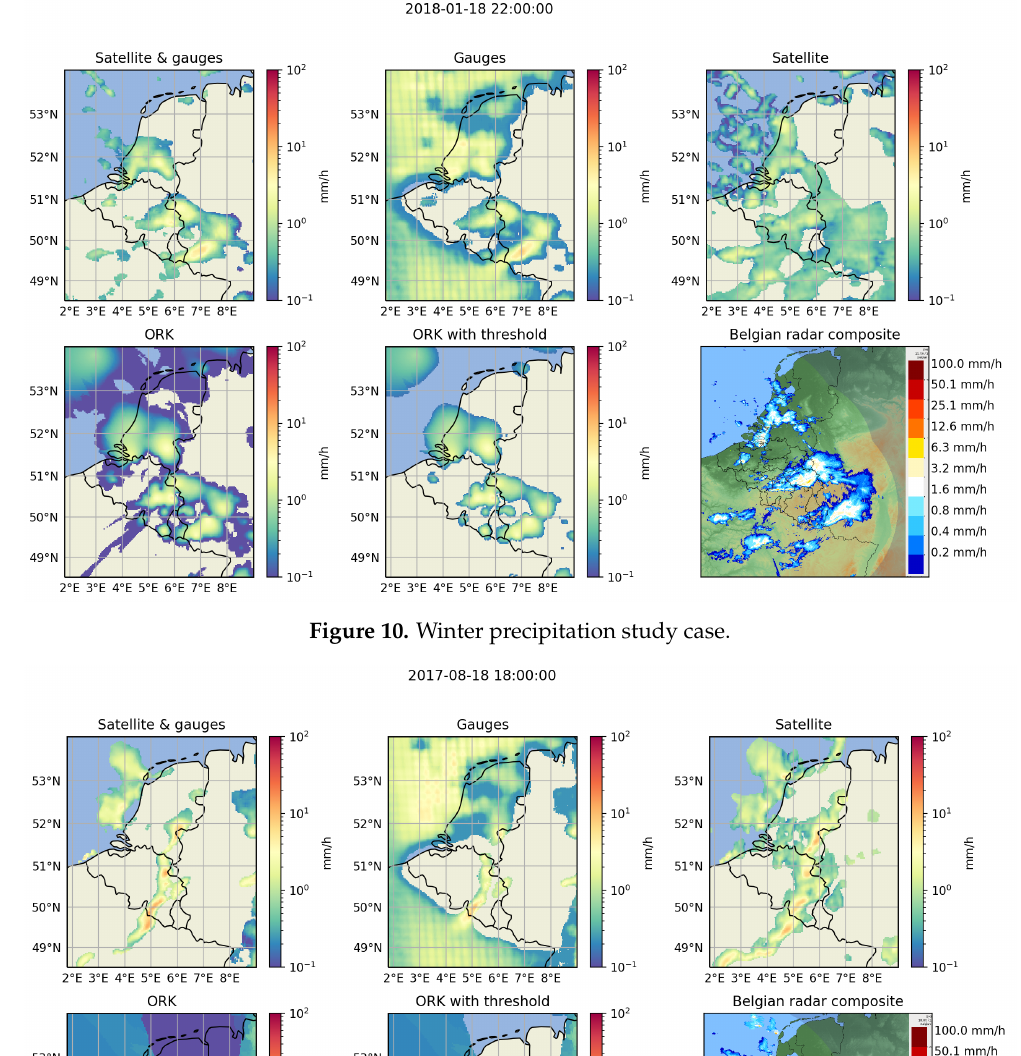
Figure 11. Summer precipitation study